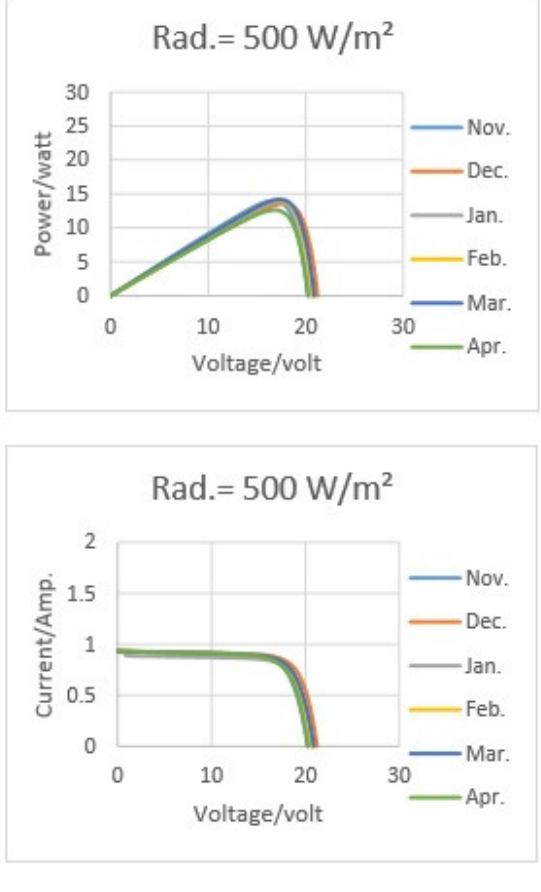
Fig. 4. P-V and I-V characteristic of monocrystalline PV solar cell at constant radiation 500W/m².